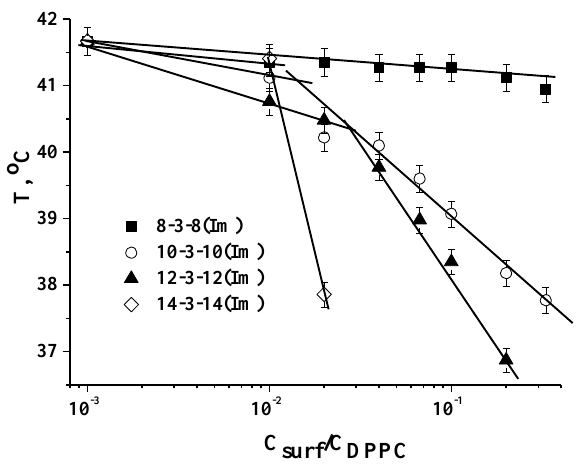
Figure 4. Dependence of phase transition temperature of DPPH liposomes on the mole ratio of sur- factant/DPPH for gemini imidazolium surfactants.